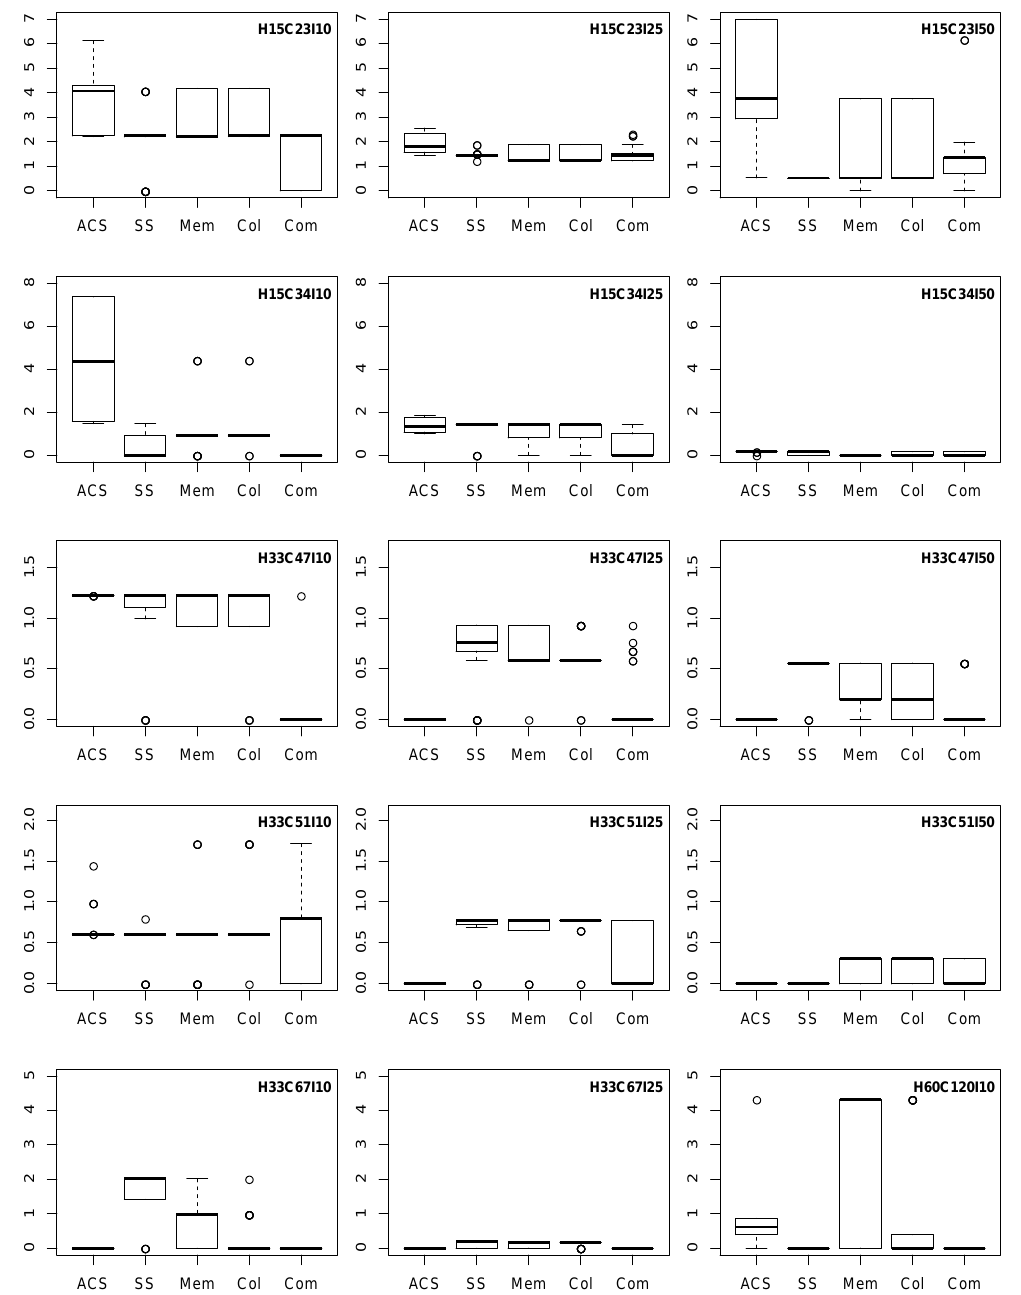
Figure 5. The 30 hypervolume values of each optimisation scheme on the instances where solutions are found by all algorithms. SS = BACS (SS), Mem = BACS (Mem), Col = BASC (Col), and Com = BACS